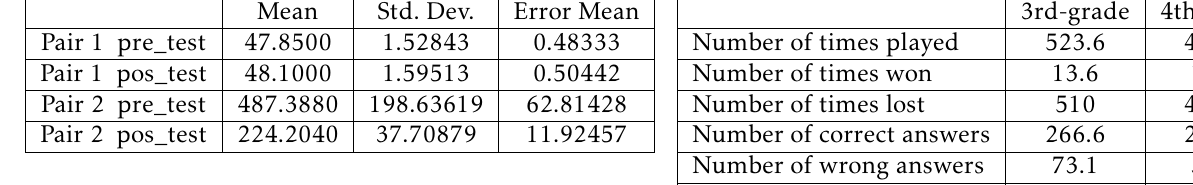
Table 2. Paired Samples Statistics - G2-PGH.